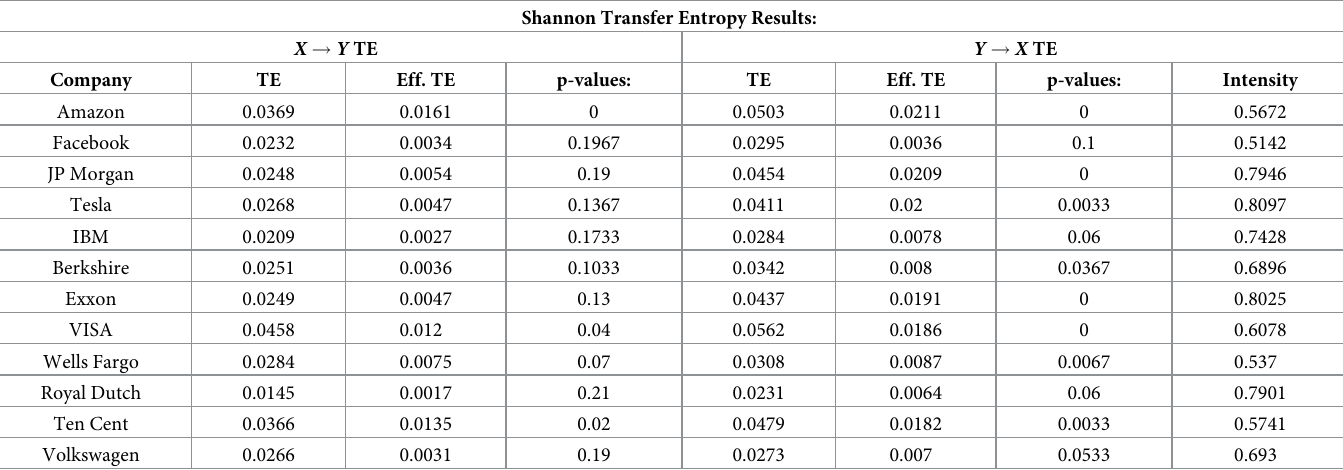
Table 2. Information flux from Y ! X TE.